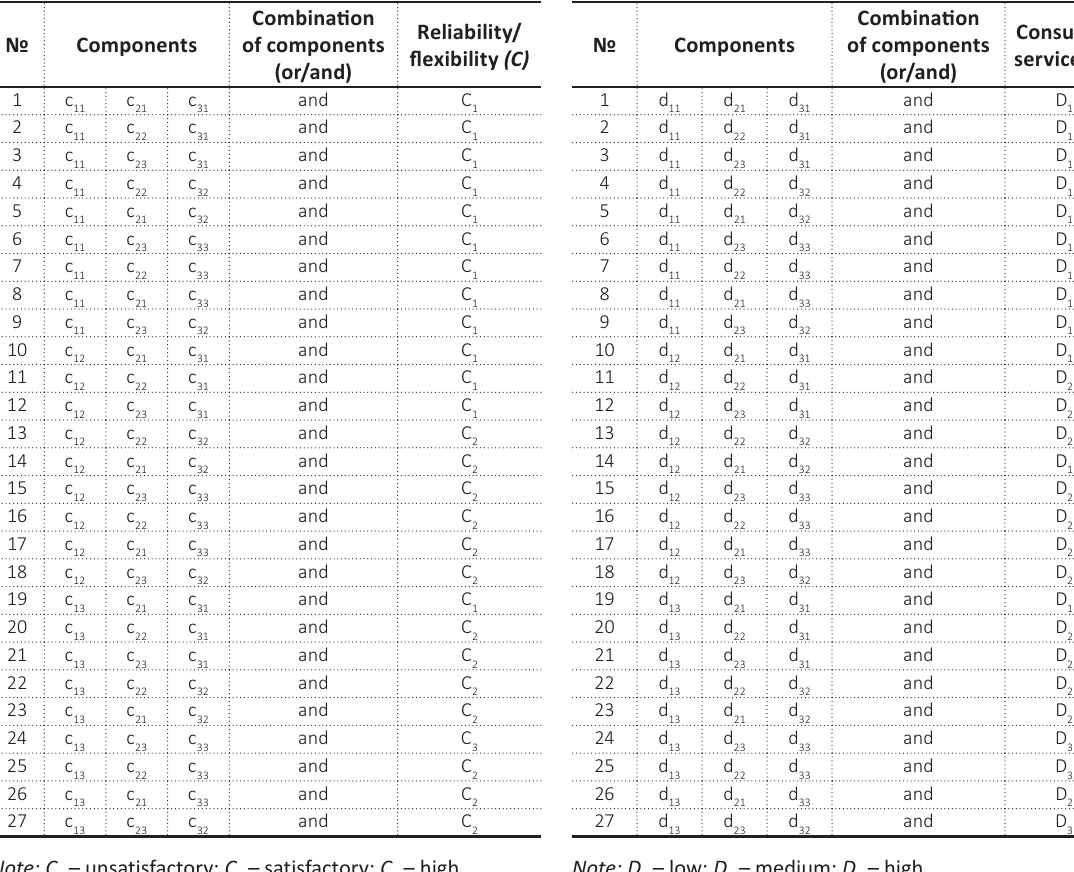
Table A9. Rules for forming an assessment of the quality of logistics service of logistics operators/ providers (S)